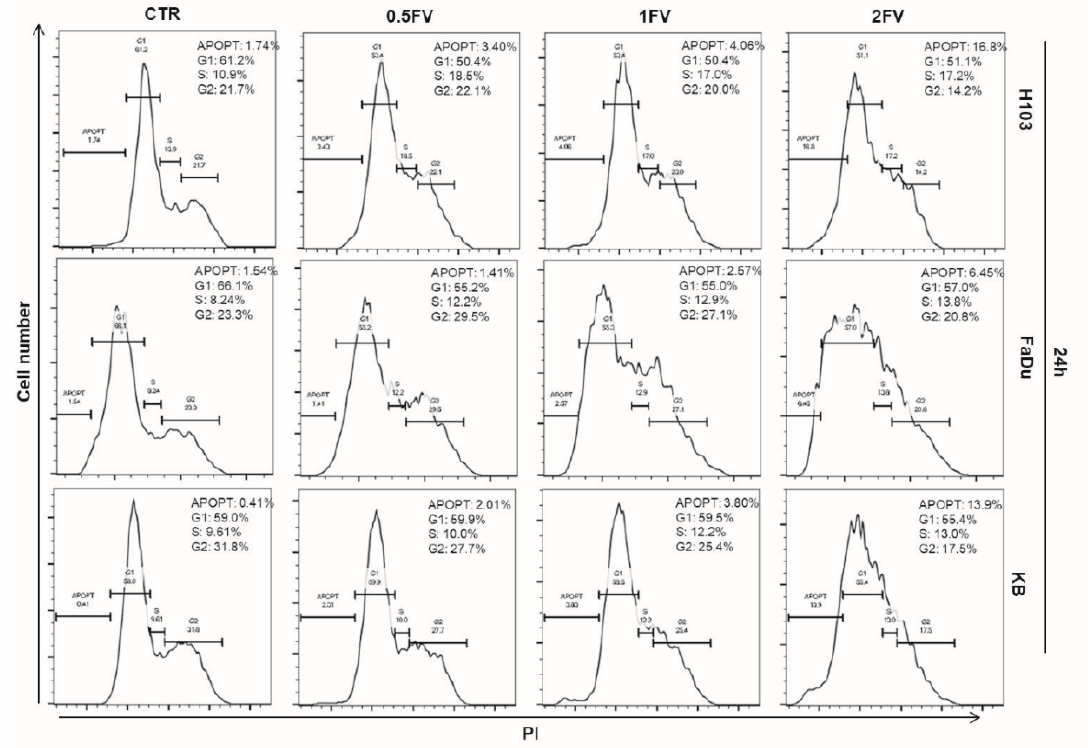
Figure 2. Impact of fucoidan on cell cycle distribution of HNSCC cell lines: H103, FaDu, KB. Cell cycle analysis after incubation with different concentrations of fucoidan for 24 h. Increasing dose of fucoidan increases the number of apoptotic cells in all tested cell lines. Treatment with fucoidan induces G2/S arrest in H103 and FaDu cells, and G1 arrest in KB cell line. (CTR—control, 0.5FV—half-fold of IC50 concentration, 1FV—IC50 concentration, 2FV—2-fold of IC50 concentration, PI—propidium iodide).